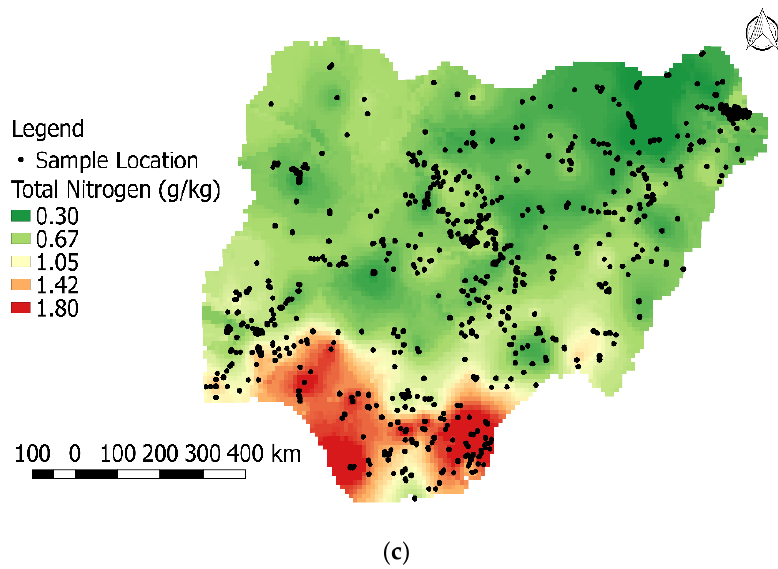
Figure 7. Interpolated surfaces for ( a ) bulk density, ( b ) organic matter, and ( c ) total nitrogen using the ordinary Kriging technique.